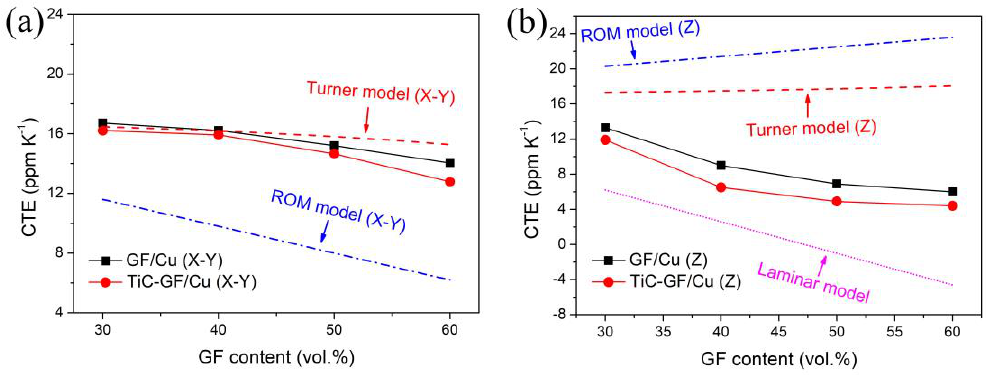
ff erent GF content: ( a ) X - Y plane; ( b ) Z Figure 13. CTE of the composites with different GF content: ( a ) X - Y plane; ( b ) Z direction. Figure 13. CTE of the composites with di